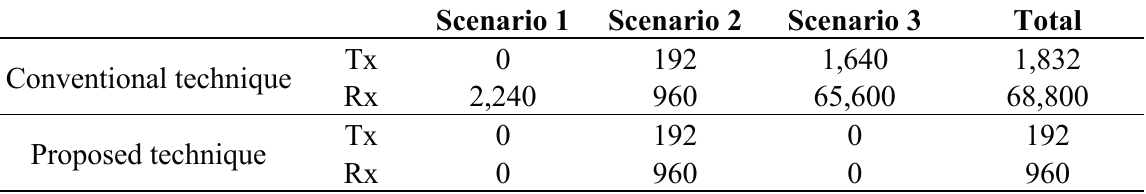
Table 4. Number of beam switches required for beam-tracking in three different